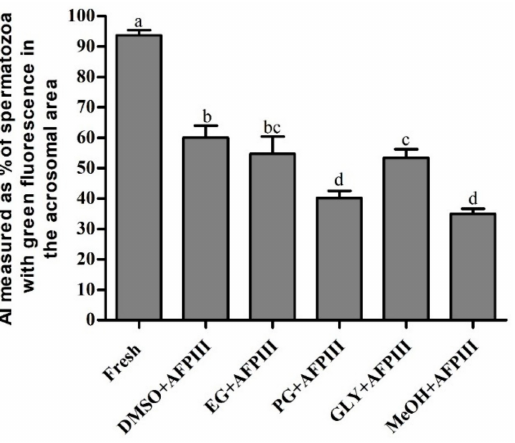
Figure 4. Acrosome integrity (AI) (%) of Pacific abalone sperm cryopreserved with antifreeze protein III (AFPIII). Significantly different levels ( p < 0.05) are denoted by different letters.